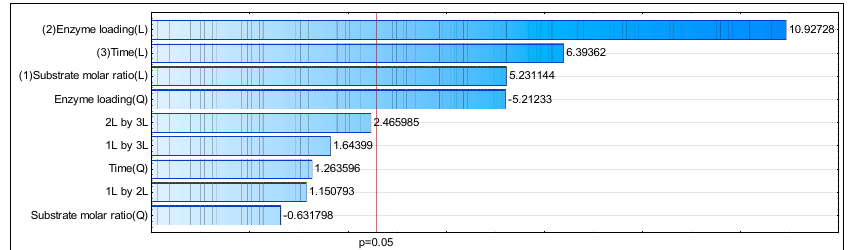
Figure 3. Pareto diagram for the effects of the analyzed variables.